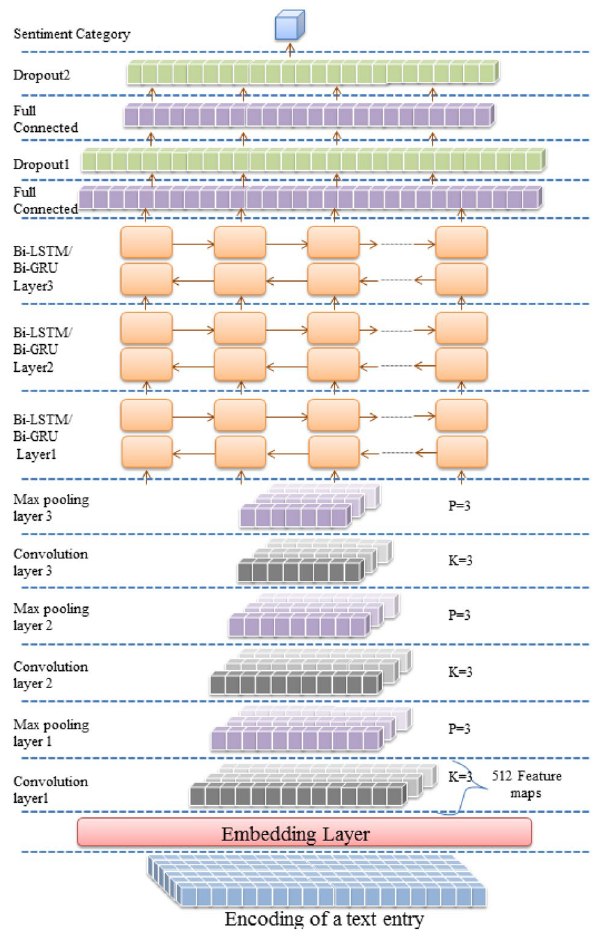
Figure 4. CNN-Bi-LSTM/CNN-Bi-GRU architecture (created by Microsoft PowerPoint